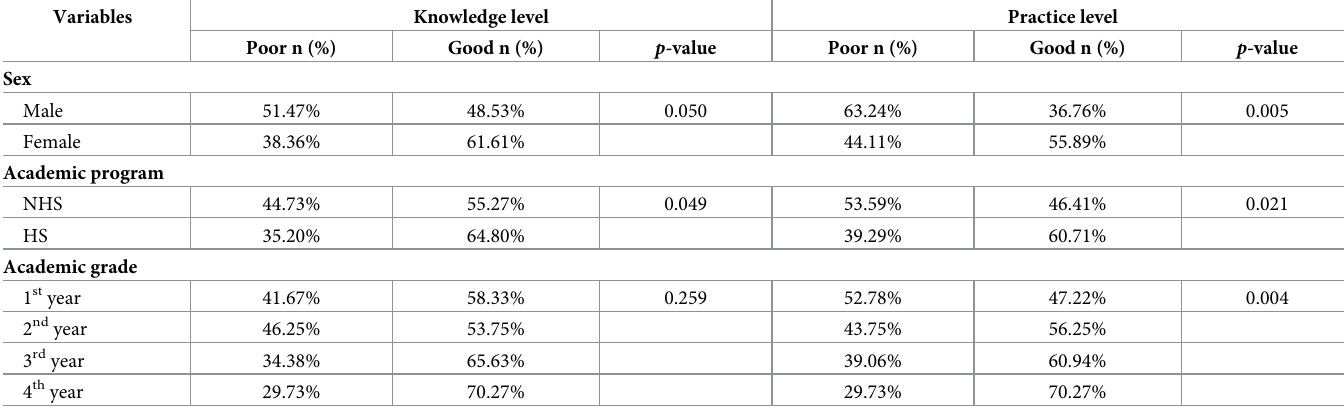
Table 2. Responses to the questions related to facemask disposal knowledge and practices. Variables